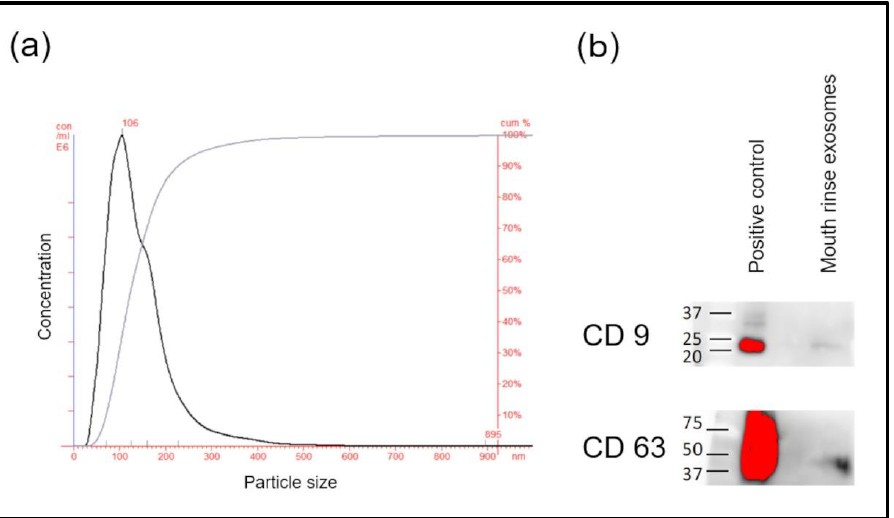
Figure 1. Confirmation of exosome pellets. ( a ) Exosome size distribution analyzed using nanoparticle tracking. ( b ) Western blots of exosome-specific markers, CD9 and CD63.